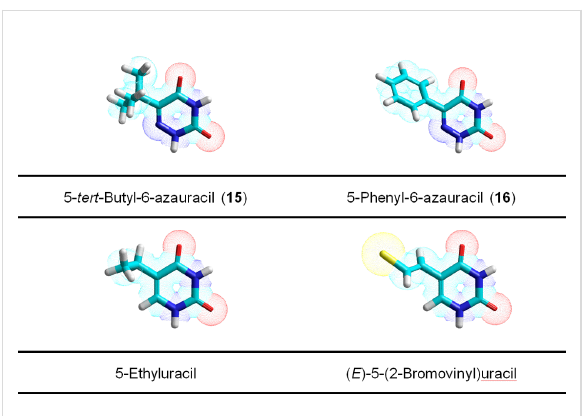
Figure 8: Geometry optimized structures (PM3 method) of 5- tert -butyl- 6-azauracil ( 15 ) and 5-phenyl-6-azauracil ( 16 ) (upper structures) vs those of 5-ethyluracil and ( E )-5-(2-bromovinyl)uracil (lower